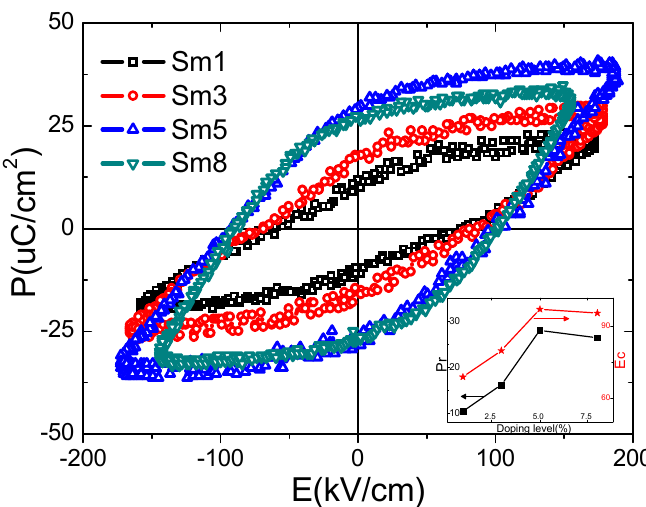
Figure 7. The ferroelectric P–E hysteresis loops of the 825 ° C-sintered samples. The insets in the figure show the composition dependency of remnant polarization/coercive field (P r /E c ).